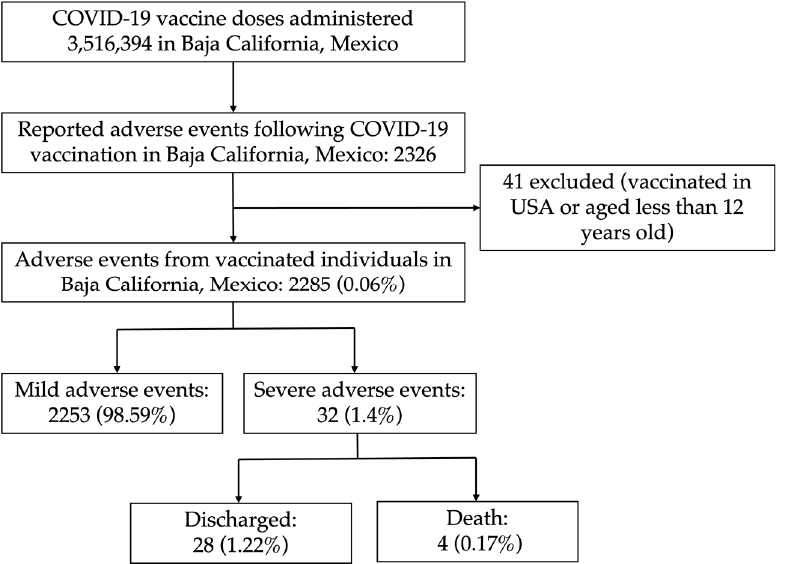
Figure 2. Adverse events following COVID-19 vaccination were reported through the state epidemio- logical surveillance system in Baja-California, Mexico.